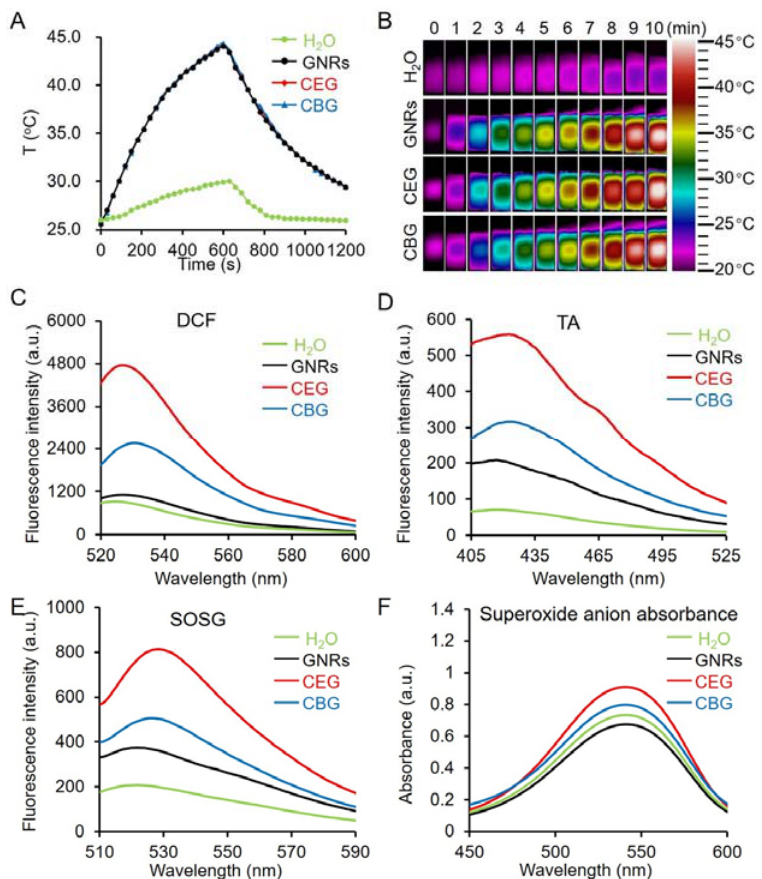
Figure 3. The photothermal and photodynamic performance of GNRs, CEG, and CBG NRs. ( A ) Heating and cooling curves and ( B ) infrared thermal images of GNRs, CEG, CBG NRs, and H 2 O. Total ROS, abiotic • OH, 1 O 2 , and O 2 •− assessments of GNRs, CEG, and CBG NRs (OD = 1) upon 808 nm laser irradiation (1 W/cm 2 , 10 min) assessed by DCF ( C ), TA ( D ), SOSG ( E ) and superoxide anion assay ( F ),